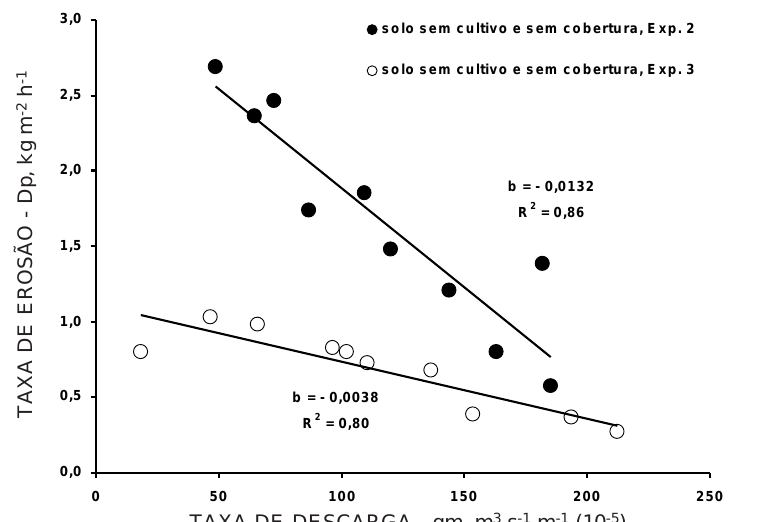
Figura 5. Relação da taxa média de erosão, Dp, com a taxa de descarga no ponto médio da parcela, qm, no tratamento solo sem cultivo e sem cobertura (Experimentos 2 e